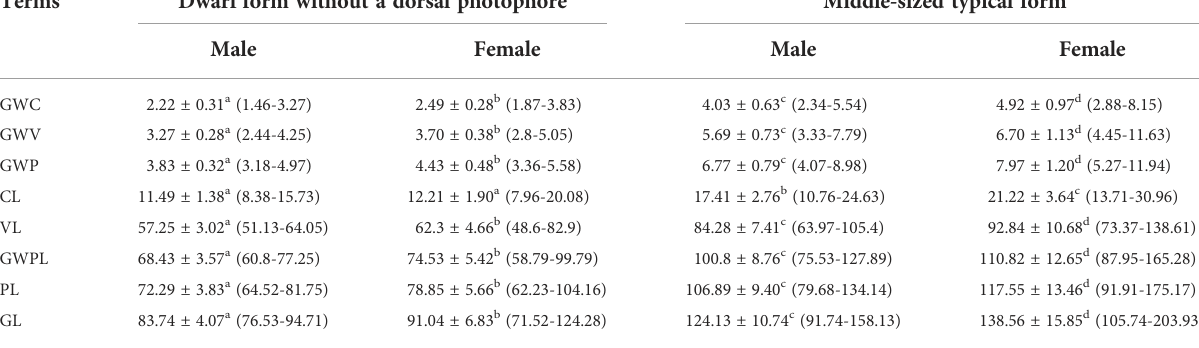
TABLE 1 Measurements of gladius morphometric characteristics (mean ± SD, mm) for dwarf without a dorsal photophore and middle-sized typical form Sthenoteuthis oualaniensis in the South China